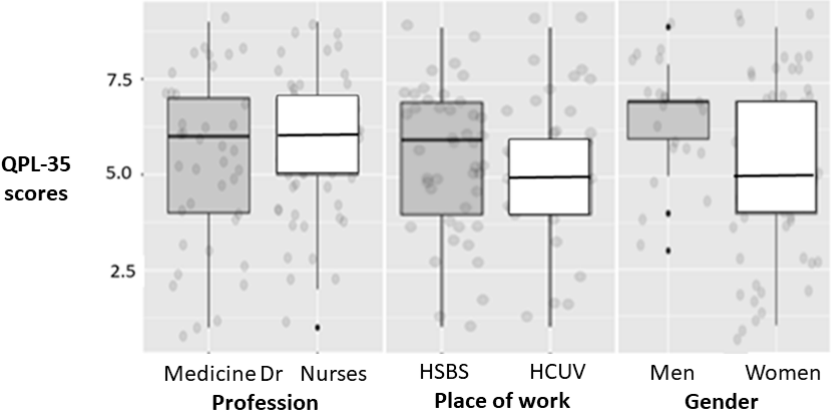
Figure 1. Dispersion of Professional quality of life (QPL-35 questionnaire) in the studied participants. Abbreviations used: HCUV (Hospital Clínico Universitario de Valladolid), HSBS (Hospital Santa Bárbara de Soria). Boxplots for the different groups showing medians and interquartile ranges.